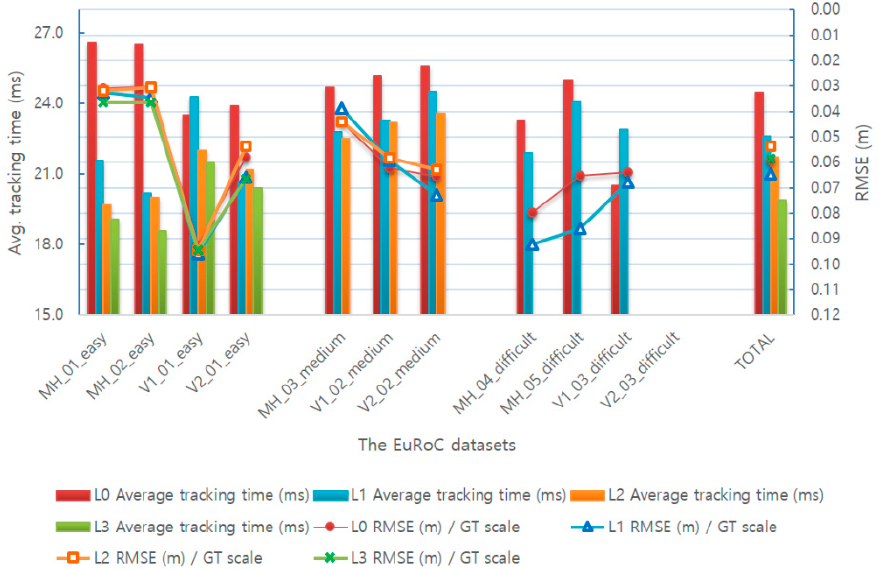
Figure 14. Comparison of the average tracking time and translation RMSE of keyframe trajectory with different level-sets of AVIO-based SLAM.